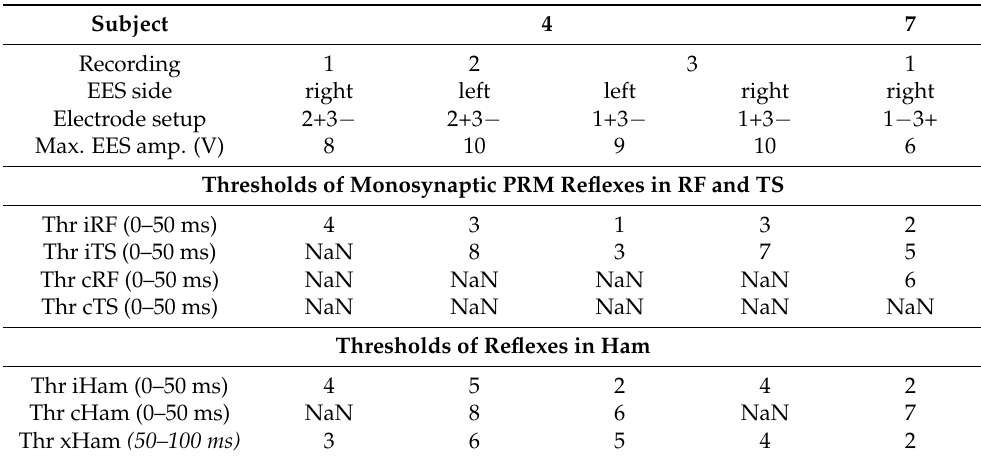
Table 2. Thresholds of ipsi- and contralateral monosynaptic PRM reflexes and crossed reflexes evoked by unilateral EES; total of five observed cases.